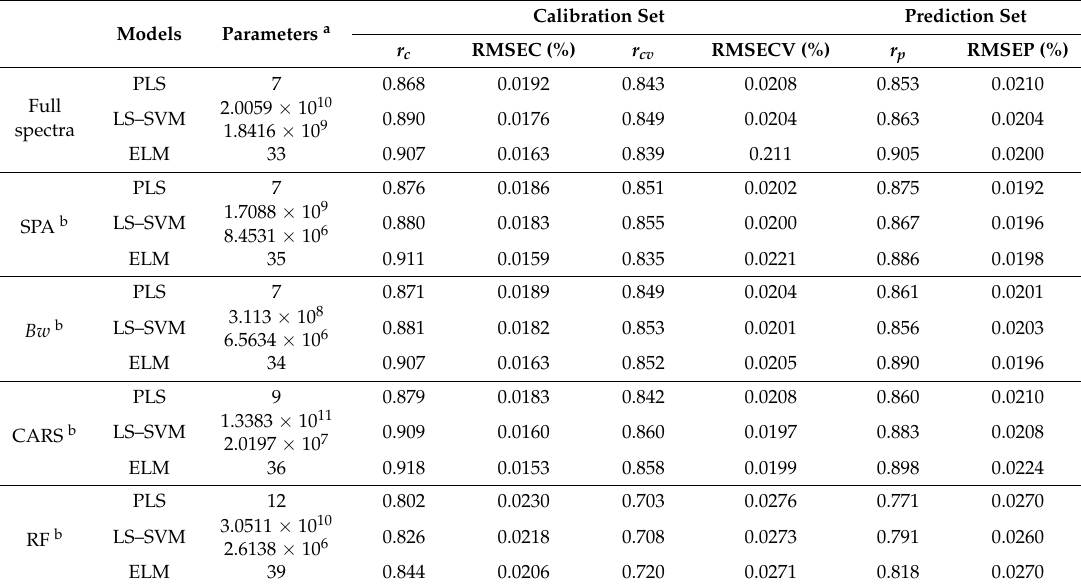
Table 3. Results of regression models for peimine content